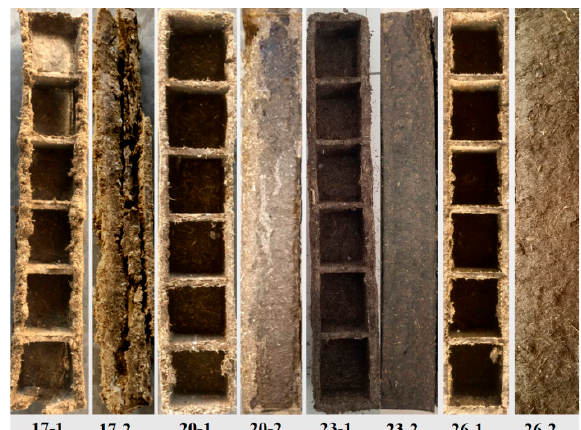
Figure 6. Regular compressed seedling trays. Note : The 17, 20, 23 and 26 represent regularly compressed seedling trays with a moisture content of 17%, 20%, 23%, and 26%, respectively. The “-1” after the numbers represent the top view under this water content, while “-2” represents the side view under this water content.